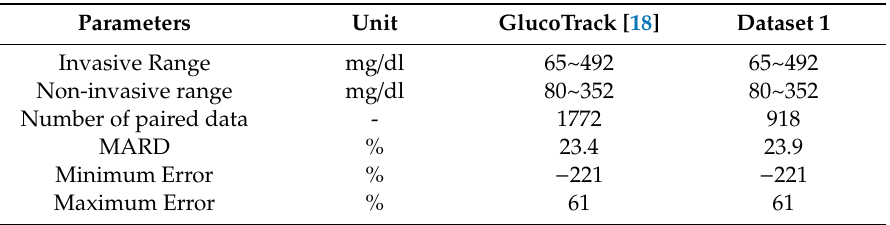
Table 5. Baseline dataset 1.